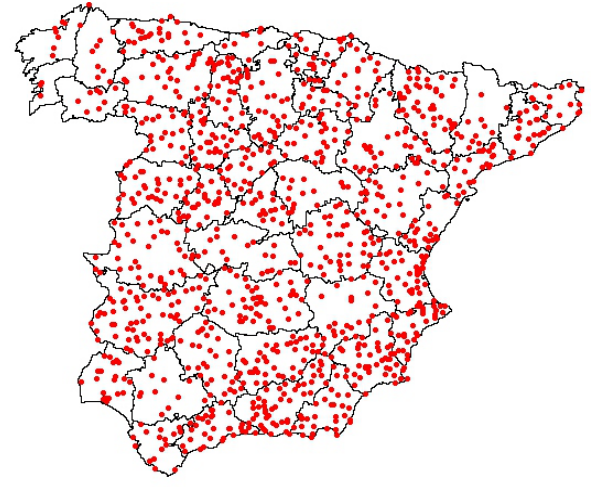
Fig. 2. Map of Spain with the 47 provinces considered. Points represent meteorological stations.